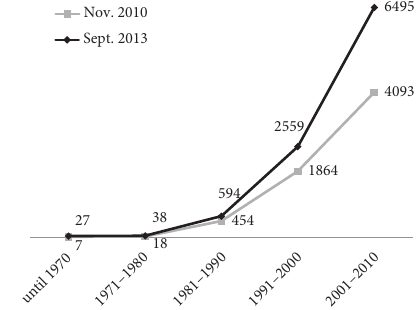
Fig. 3. Evolution, per decade, of numbers of DSS materials indexed in IEEE Xplore Digital